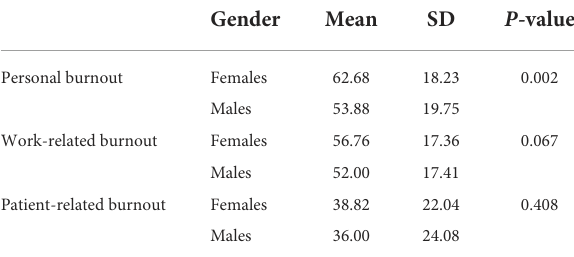
TABLE 4A One Way ANOVA Test between the mean of the three scales and marital status.